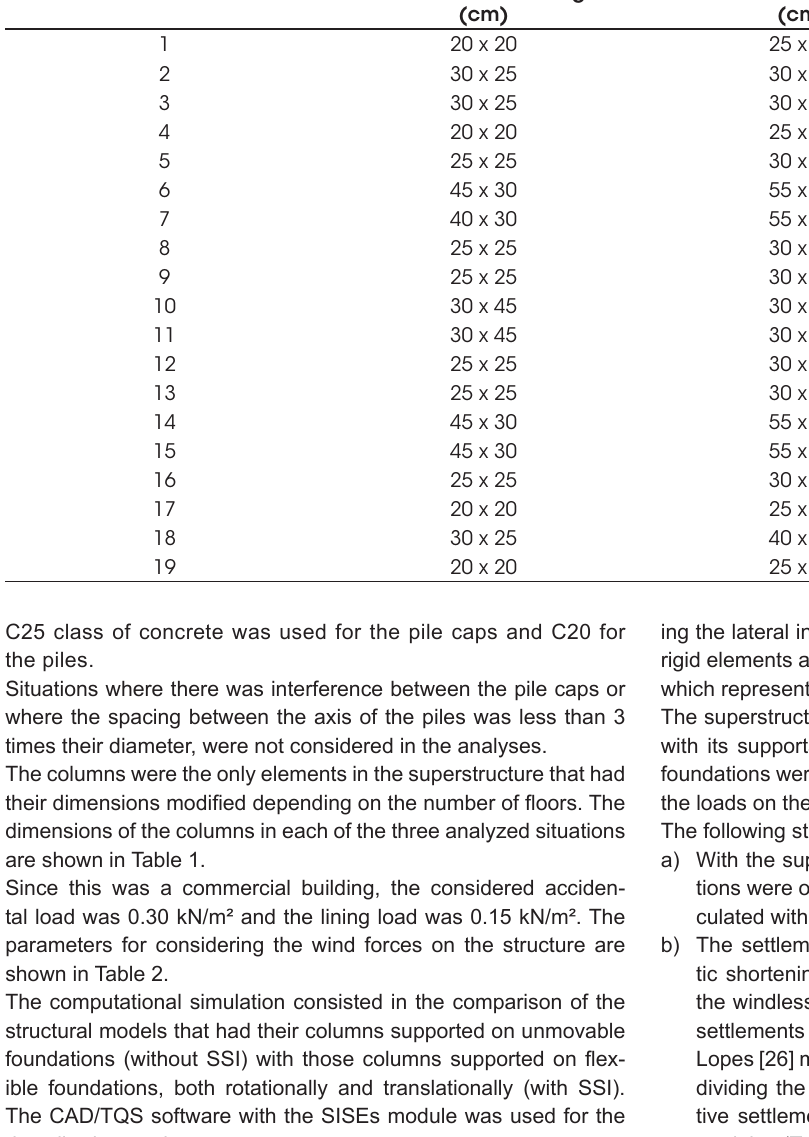
Dimension of the superstructure columns Dimensions of the columns Dimensions of the columns Column of the 4-floor buildings of the 6-floor buildings (cm)